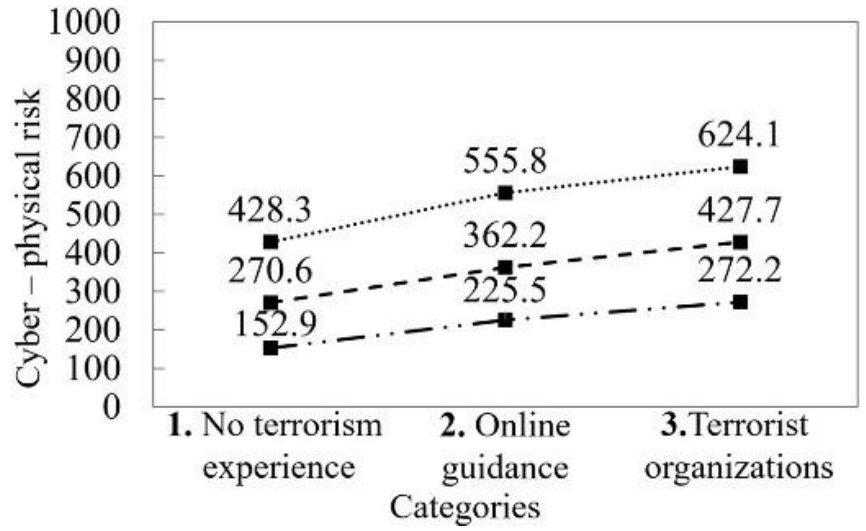
Figure 7. Sensitivity analysis considering Terrorism experience characteristic.